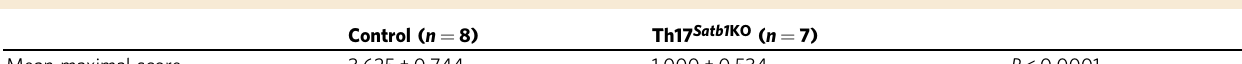
Mean maximal score